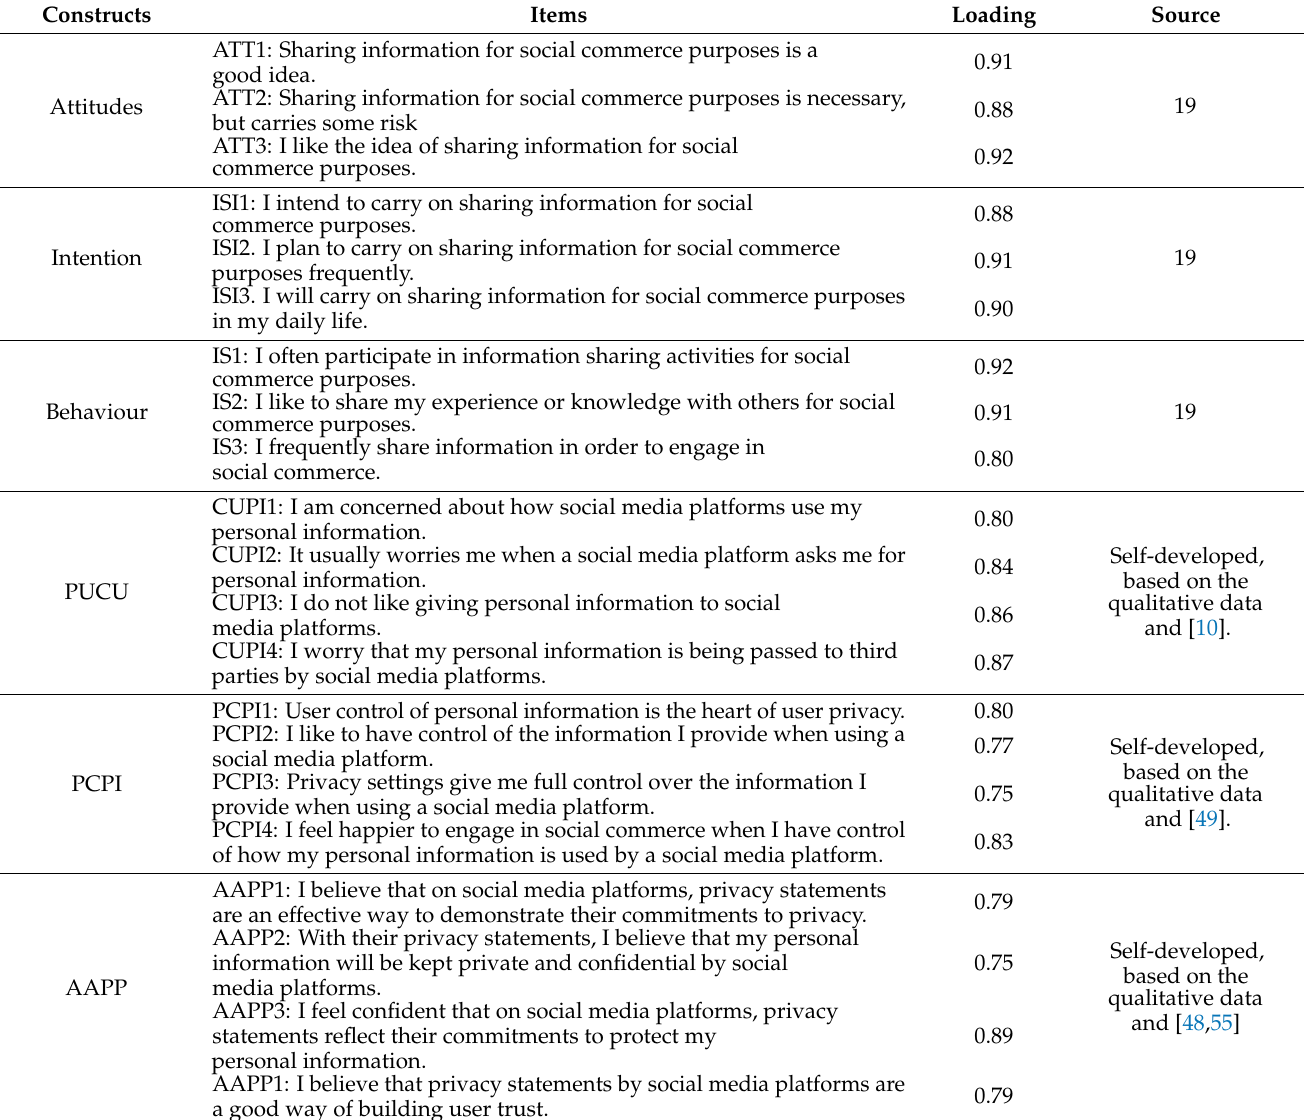
Table 2. Constructs; items with factor loadings and